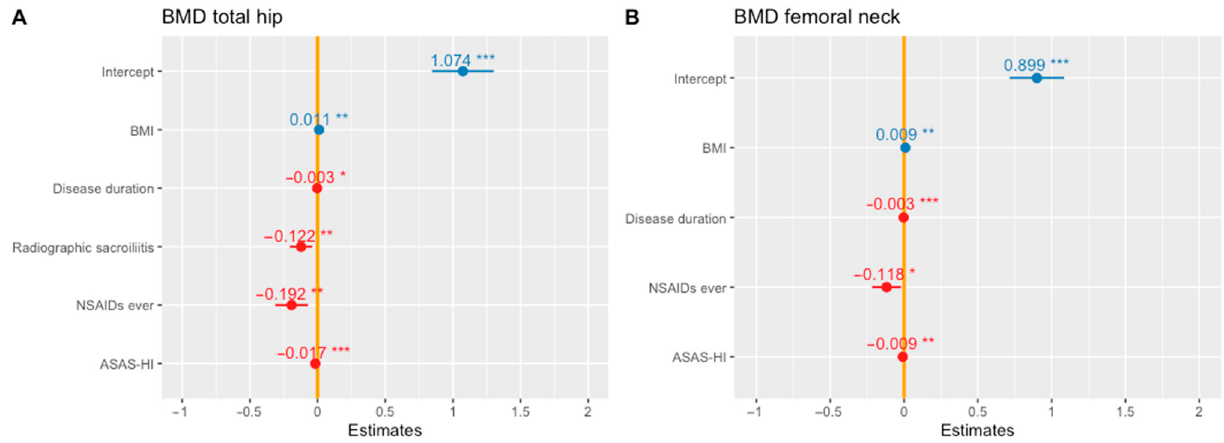
Figure 2. Multivariate generalised linear regressions to evaluate factors associated with bone mineral density in the total hip ( A ) and femoral neck ( B ). ASAS-HI: ASAS Health Index; BMI: Body Mass Index; NSAIDs: Non-steroidal anti-inflammatory drugs. *, p -value < 0.05; **, p -value < 0.01; ***, p -value < 0.001